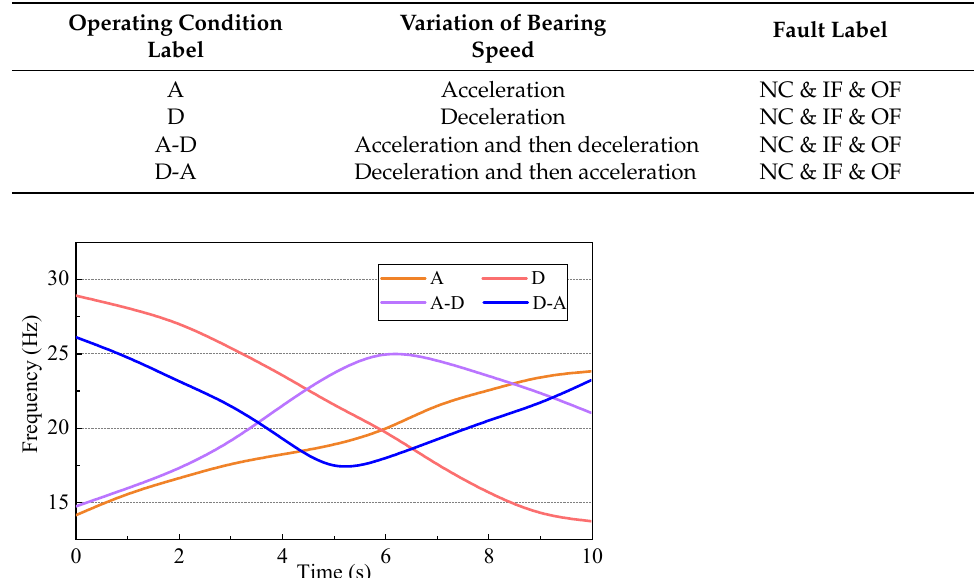
Figure 7. Rotational frequency variation in the University of Ottawa dataset for the time-varying state of the bearing speed.